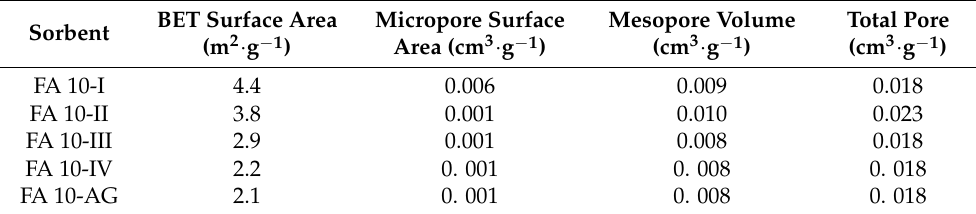
Table 3. Parameters of the porous structure of analysed fly